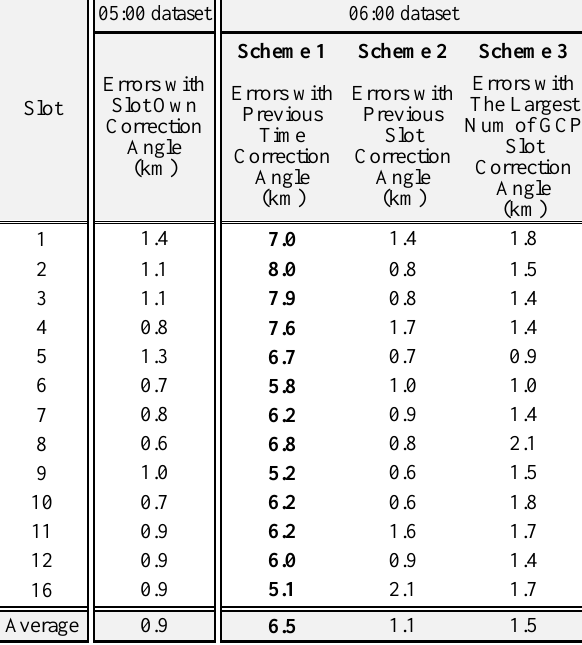
Table 2. Accuracy comparison of the three schemes in 6:00 data For some datasets, the variation of geometry between datasets was so large that the geometric correction accuracy of the scheme 1 became very poor. Table 2 is an accuracy comparison of the three schemes in 6:00 dataset. Although the correction angle in the 05:00 dataset showed good performance, the result of scheme 1 in the 06:00 dataset, which reused this correction angle, showed low accuracy. On the other hand, results of scheme 2 and 3 showed better and more stable accuracy.